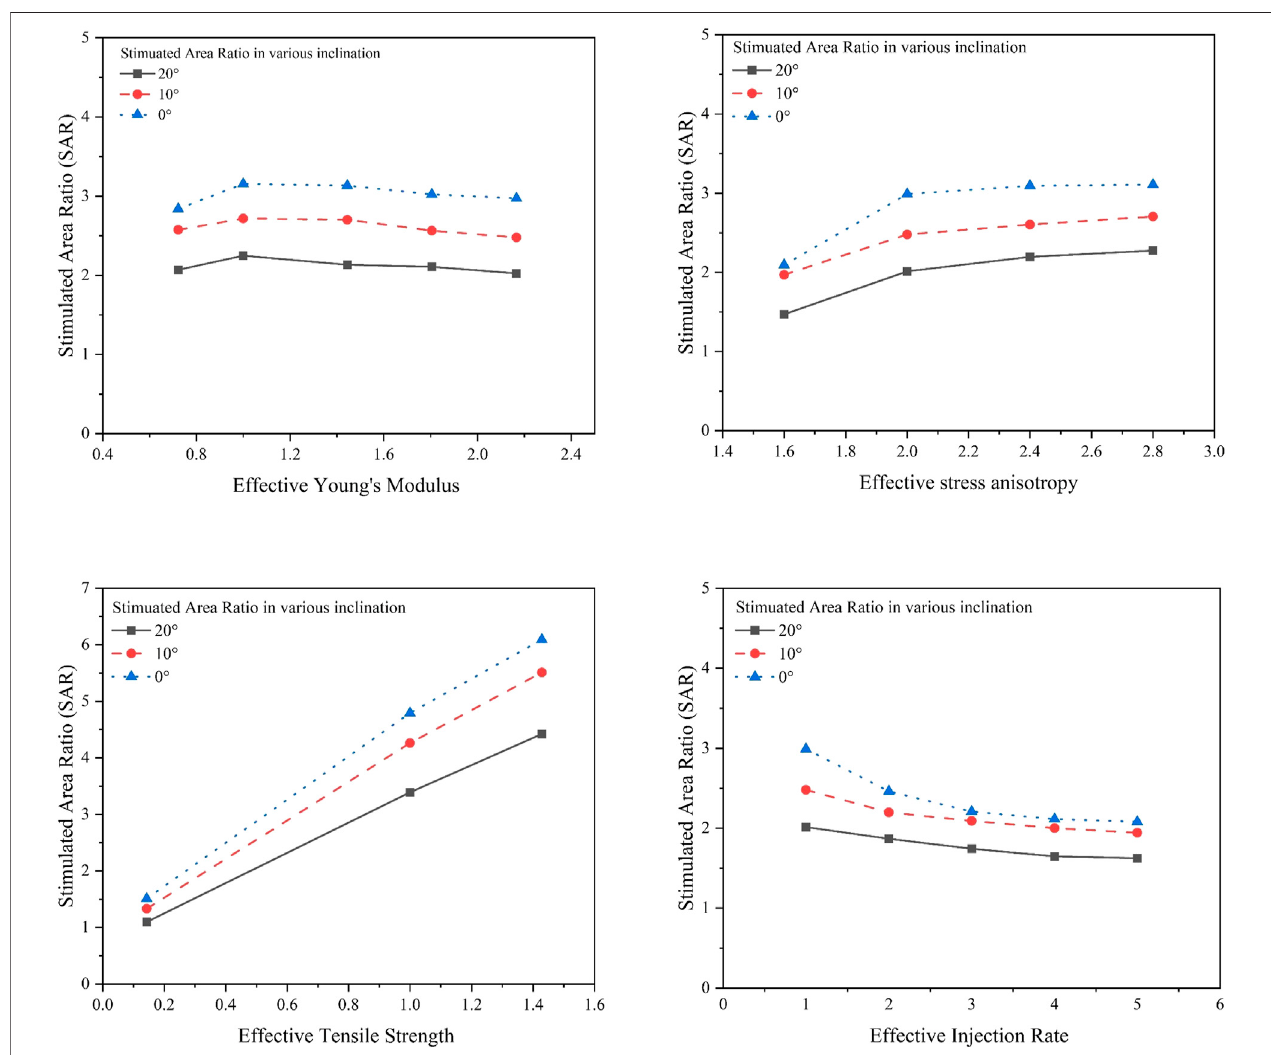
FIGURE 13 | Effect of (A) Young ’ s modulus, (B) stress anisotropy, (C) tensile strength, and (D) injection rate on stimulated area ratio (SAR).